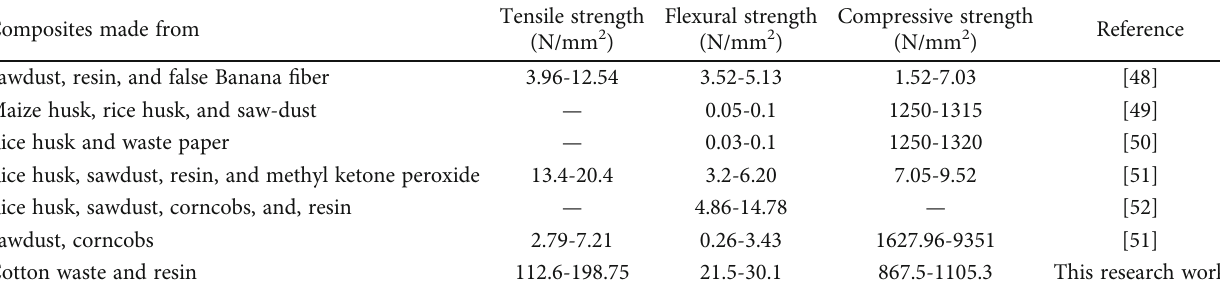
Table 6: Comparison of di ff erent ceiling board